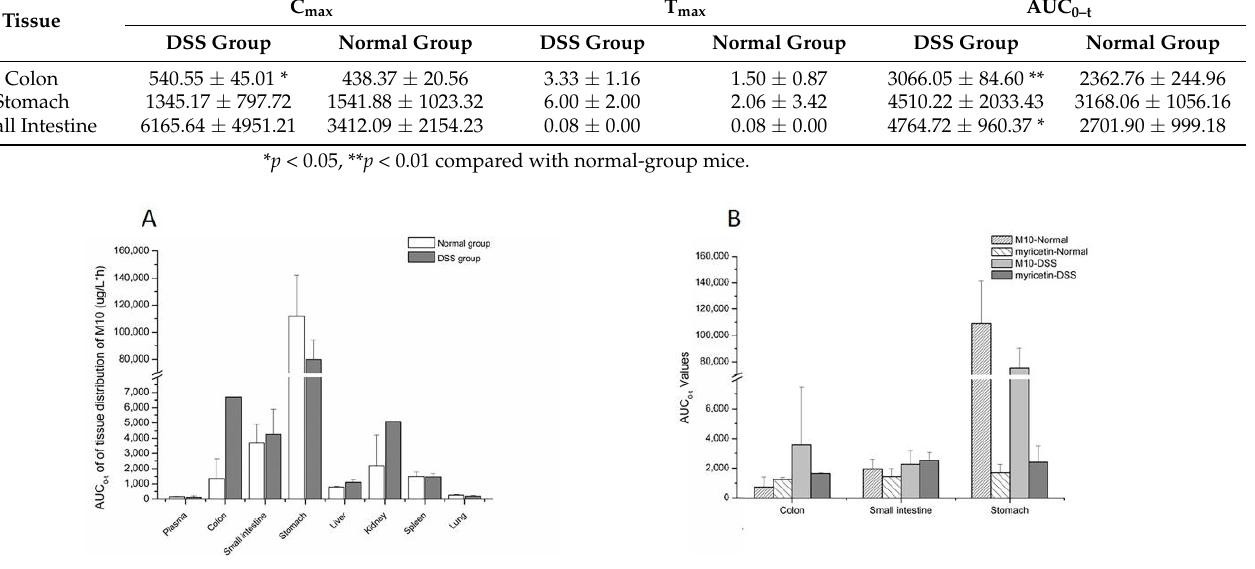
Figure 5. Incubation of M10 with fecal flora of normal mice at 37 °C (n = 3). 3. Discussion In this study, we referred to the sample- preparation method reported by Dr. Meng’s group for quantification of M10 and myricetin in mice [16]. Though M10 and myricetin feature the same precursor ion and product ion, the retention times of M10 and myricetin were 1.51 and 1.77 min, respectively. In previous pharmacodynamics studies of M10 [12] as well as in our pharmacodynamics study (Figure S3), the group with M10 at 50 mg/kg presented better activity than did other groups (such as 25 and 100 mg/kg). Due to limitation of the total amount of M10, we finally chose the dose of 50 mg/kg, which had the best activity to evaluate pharmacokinetics of M10 in mice. However, a potential limitation is that dose linearity from 25 to 100 mg/kg was unknown. According to profiles of pharmacokinetics, T 1/2 and MRT of M10 in DSS-group mice were lower than those in normal-group mice. In colitis status, C max of M10 was obviously higher than in normal mice; meanwhile, the AUC was not enhanced in colitis mice. This phenomenon might be the result of a corresponding pathologic change in colitis mice, which had higher colonic permeability than normal mice. The volume of distribution (V) of M10 in the DSS group